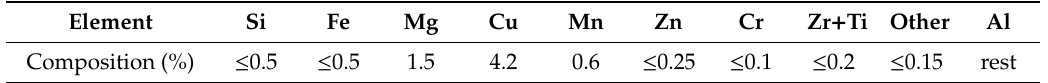
Table 1. Chemical composition of 2024 aluminum alloy